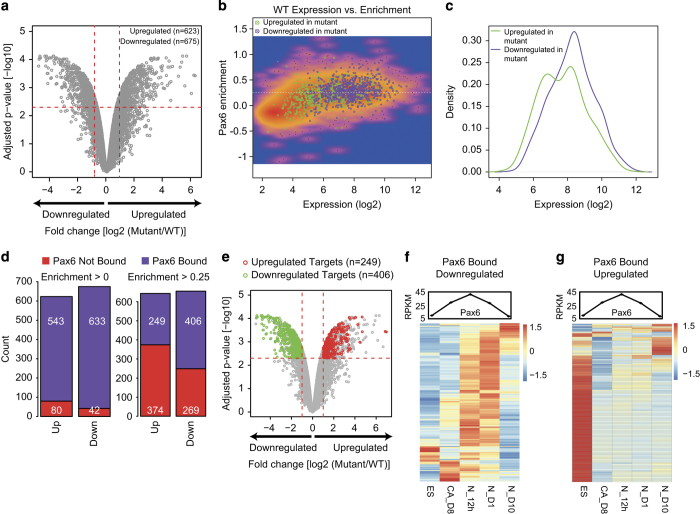
Pax6 targets are misregulated in the absence of Pax6. (a) Volcano plot showing changes in expression of genes in WT and Pax6 mutant (mutant). x axis represents fold change in log2 scale between WT and mutant, and the y axis shows level of significance as in –log10 of adjusted P-value. Vertical dotted red lines reflect a two-fold cutoff for expression while horizontal dotted red lines represent a P-value cutoff of 0.005. (b) Scatter plot showing log2 of expression levels in WT (x axis) and Pax6 enrichment on y axis. Upregulated (green) and downregulated (purple) genes in Pax6 mutant are highlighted as dots. (c) Density plot to show the WT expression of upregulated and downregulated genes shown in b. y axis represents the density while x axis represents the expression levels. (d) Stacked bar plots showing that the substantial subset of differentially regulated genes in Pax6 mutants are Pax6 targets (two different Pax6 promoter enrichment cutoff: >0 (low stringency, left panel), >0.25 (high stringency, right panel). (e) Volcano plot as described in a but highlighting only upregulated (red dots) and downregulated (green dots) genes that are Pax6 targets in WT cells. (f, g) Heat maps showing the expression in ES, CA, N_12h (neurons at 12 h), N_D1 (day 1 neurons) and N_D10 (neurons at day 10) of Pax6-bound genes that are significantly downregulated (f) and upregulated (g) in Pax6 mutant progenitors. Line plots above the heat maps show expression of Pax6 in the same stages.